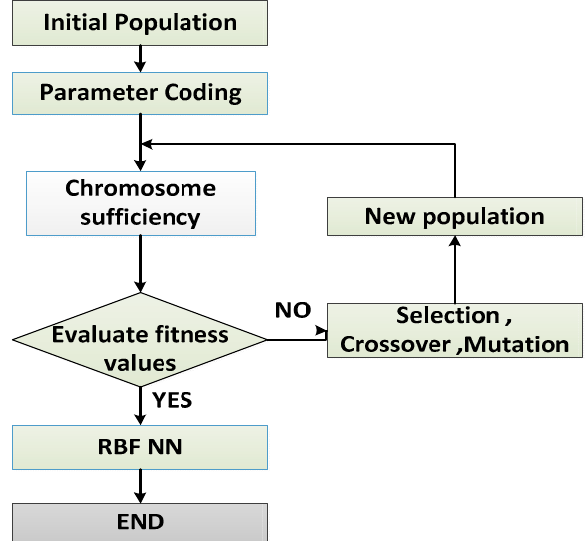
Figure 6. The process of RBF NN based on GA (RBF NN + GA).